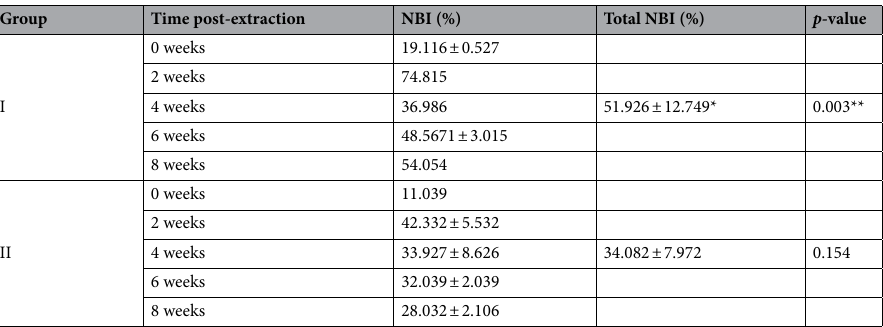
Table 8. Comparison of necrotic bone indicator percentage (NBI) in IP BRONJ model group I and II over time. The statistical analysis was performed using ANOVA. The data are depicted as the mean ± standard deviation. *The NBI percentage in group I was significantly higher than that in group II ( p < 0.05). **Significant differences in necrotic bone indicator percentage were found within group I ( p < 0.05).